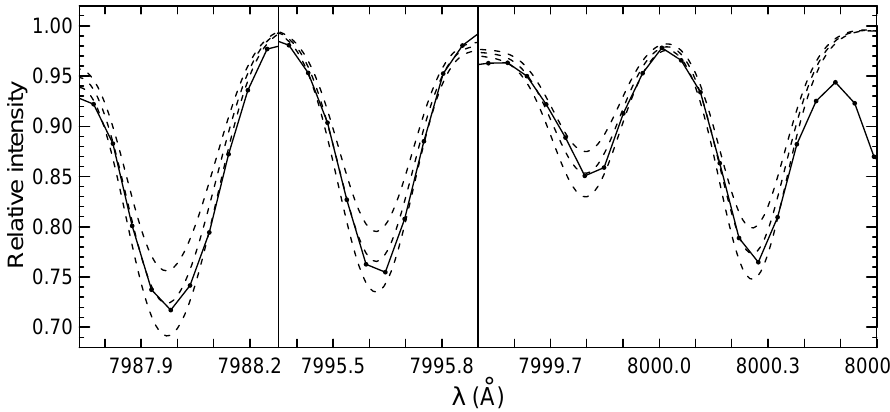
Fig. 5. Synthetic spectrum fits to 12 CN lines. The observed spectrum is shown as a solid line. The dashed lines are synthetic spectra with [N = Fe] = 0 : 13, 0.23 and 0.33 dex.